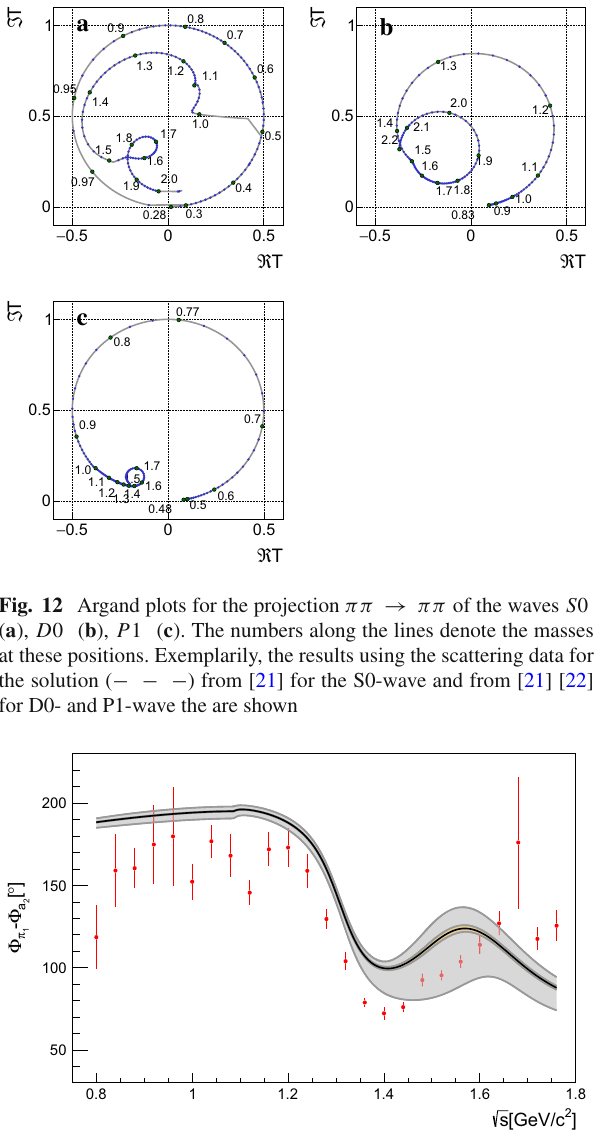
Fig. 13 Phase difference between the a 2 and the π 1 wave in πη . The red dots with error bars show the COMPASS data for the P- and D-wave of the ηπ system in diffractive π − p scattering [38]. The corresponding result for the πη channel extracted from the a 2 and the π 1 scattering matrices T πη → πη obtained from the best fit in ¯ pp annihilation is repre- sented by the black line. For comparative purposes the obtained phase difference is shifted by an offset of 180 ◦ . The gray shaded area repre- sents the systematic uncertainty obtained from the alternative fits listed inTable2andtheyellowbandillustratesthestatisticaluncertaintybased on the covariance error matrix from the MINUIT2 fit. Note that this fig- ure does not show a fit to the COMPASS data but merely a comparison Most of the obtained quantities are in good agreement with other measurements [8]. It should be noted that the f 0 ( 500 ) exhibits a larger mass and width. This is probably related to the chosen K-matrix approach. The description chosen here does not take into account properly crossing symmetries and other sophisticated constraints for the low ππ mass region,